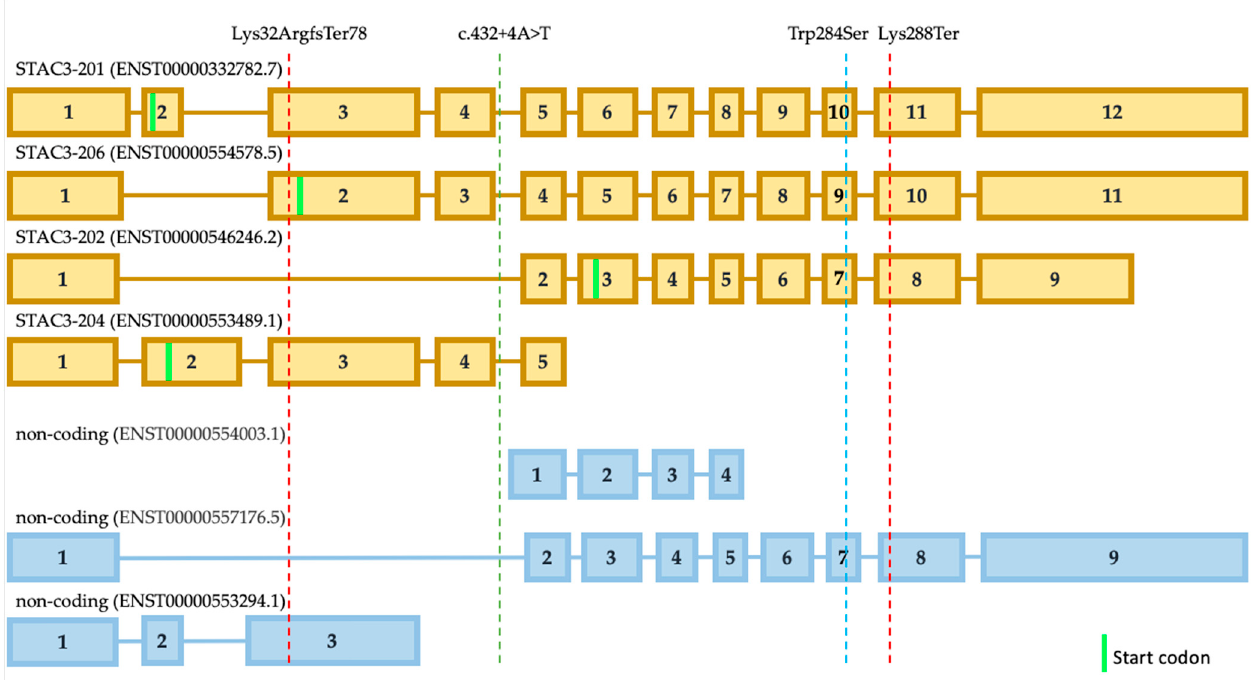
Figure 3. The predicted localization of SNVs on coding and non-coding isoforms of the STAC3 gene. The red lines indicate the SNVs revealed in the presented case, the green line indicates the SNVs detected in the patient with a Turkish ancestry [4], and the blue line corresponds to a frequent pathogenic variant.